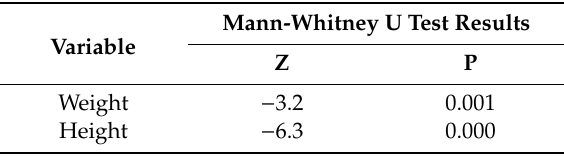
Table 2. Comparison of somatic features between groups.